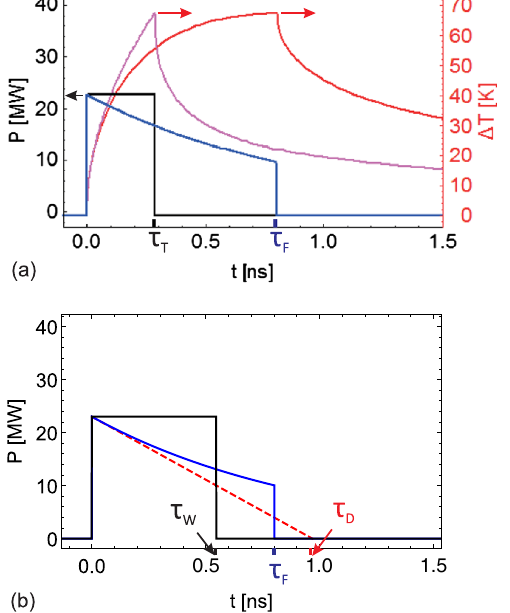
FIG. 7. Derivation of equivalent pulse lengths for gap ¼ 0 . 9 mm, a field generated by a 3.2 nC bunch of 50 μ m (without taking into account the coupler reflections). (a) The blue plot is the power pulse generated by the electron beam in the regular cell of the structure. The corresponding pulsed surface heating is the magenta plot, that reaches 67 K of peak pulsed heating. The black pulse is the equivalent square pulse “ in temperature, ” with pulse length τ , which produces the same T peak pulsed heating as the beam-generated rf pulse. Note that τ T is calculated under the constraint that the blue and black rf pulses have the same max power (at t ¼ 0 ). The red plot is the pulsed heating generated by the square pulse. (b) The blue plot is the power pulse generated by the electron beam in the regular cell of the structure. The black pulse is the equivalent square pulse “ in energy, ” with pulse length τ , which has the same pulse energy W and same max power (at t ¼ 0 ) as the blue. The red plot is used to illustrate the power decay time τ : it is the ordinate intercept of a D line tangent at t ¼ 0 to the beam-excited